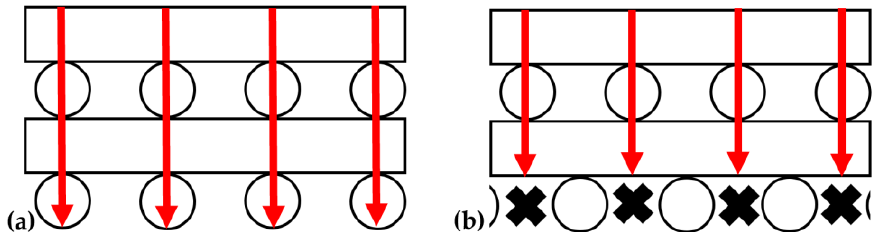
Figure 15. Thermal conductivity versus compressive strain of tungsten-filled DIW pads printed with FCT and SC lattice structures and 500 µm center-to-center strut spacing.